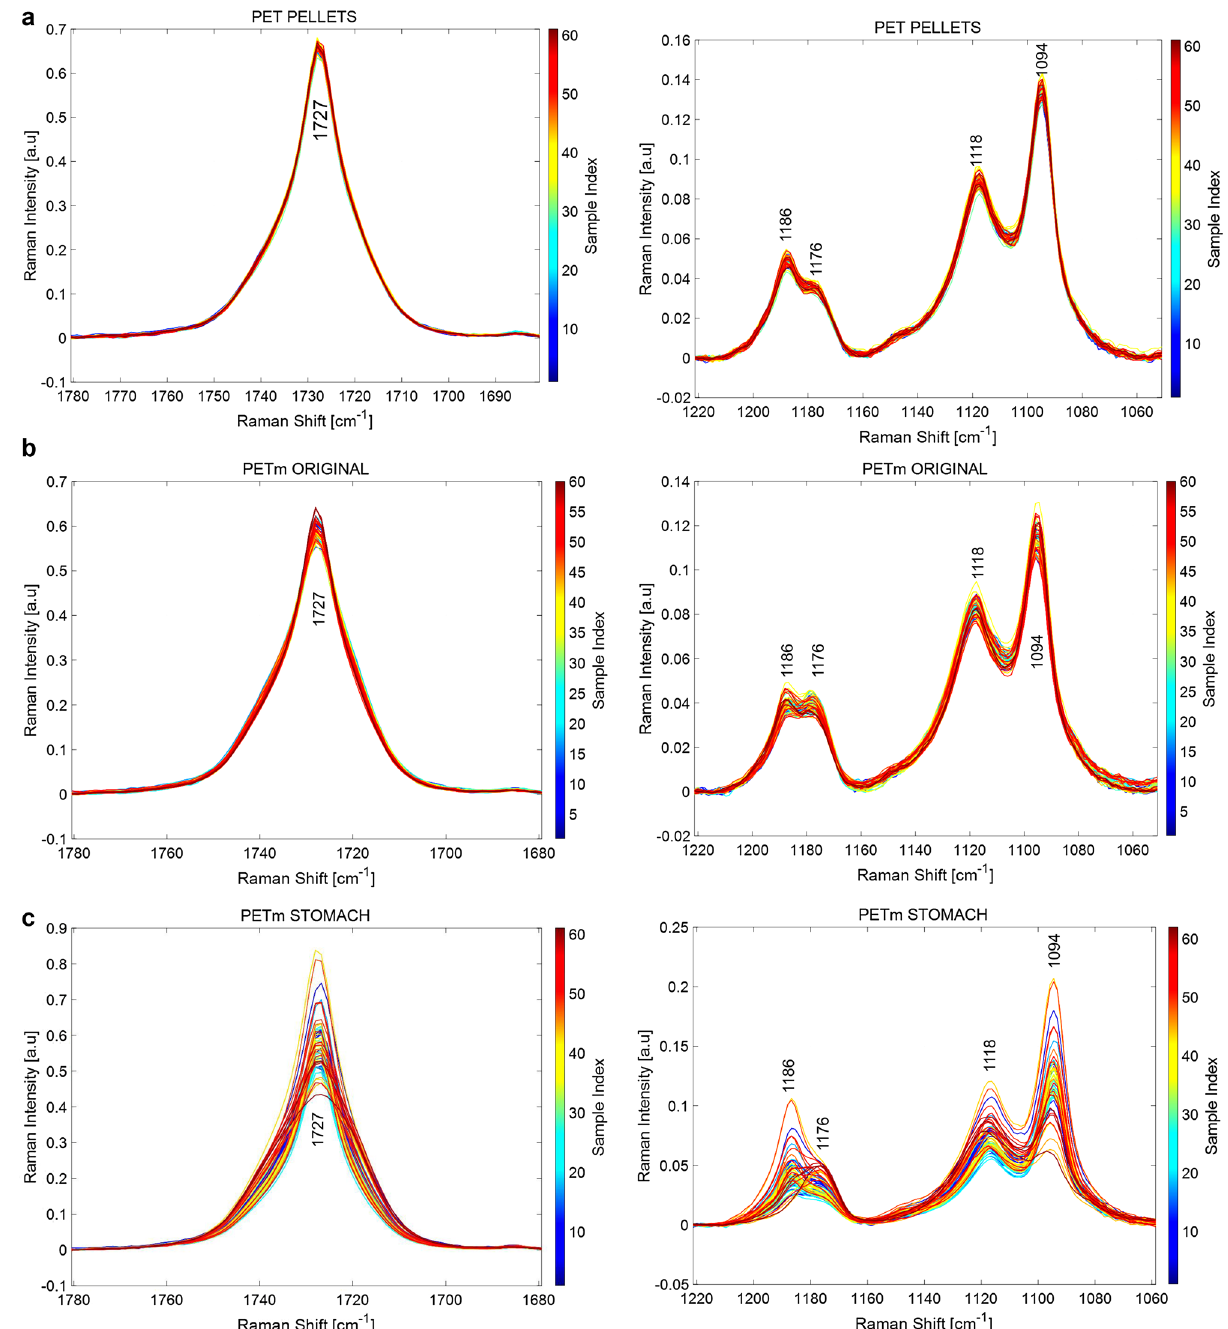
Figure 2. Raman spectra at 60–70 representative points of PET pellets ( a ); original PET microplastics (MPs) ( b ); PET MPs after in vitro gastric digestion ( c ); PET MPs after in vitro gastrointestinal digestion ( d ); and PET MPs after in vitro gastrointestinal digestion and colonic fermentation for volunteer 1 ( e ). ( f ) show the evolution of relative intensity of 1118 modes vs. 1094 cm −1 during digestion